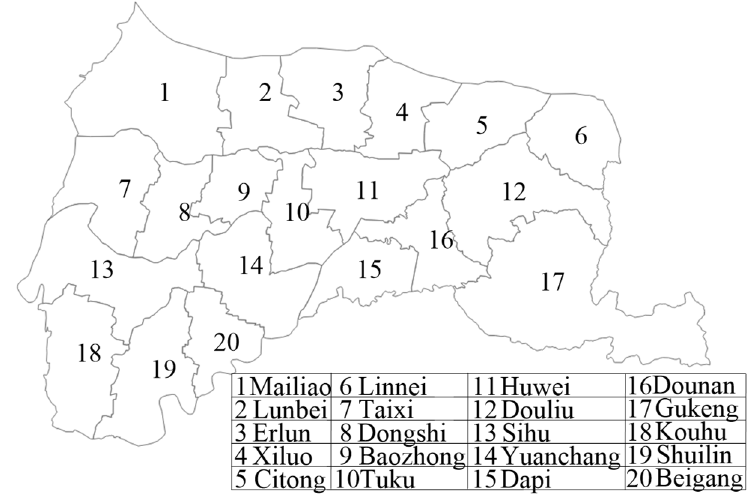
Figure 12. Sub-administrative regions of Yunlin County.